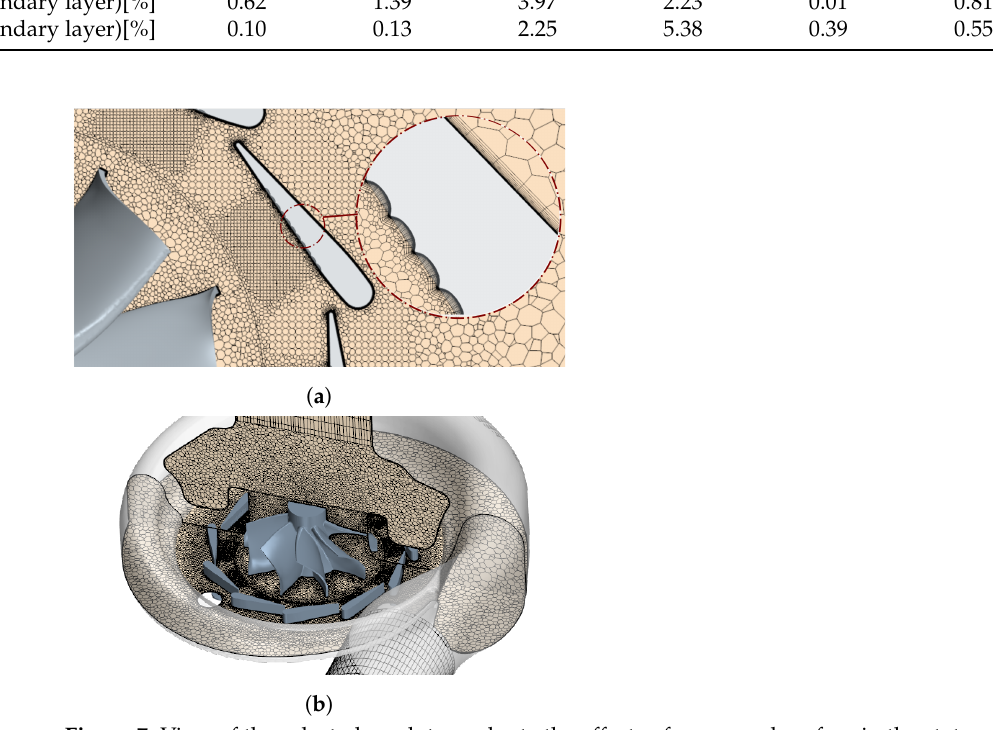
Figure 7. View of the selected mesh to evaluate the effects of a grooved surface in the stator vanes. ( a ) Top view. ( b ) 3D view. Table 4. Average values of different mesh quality